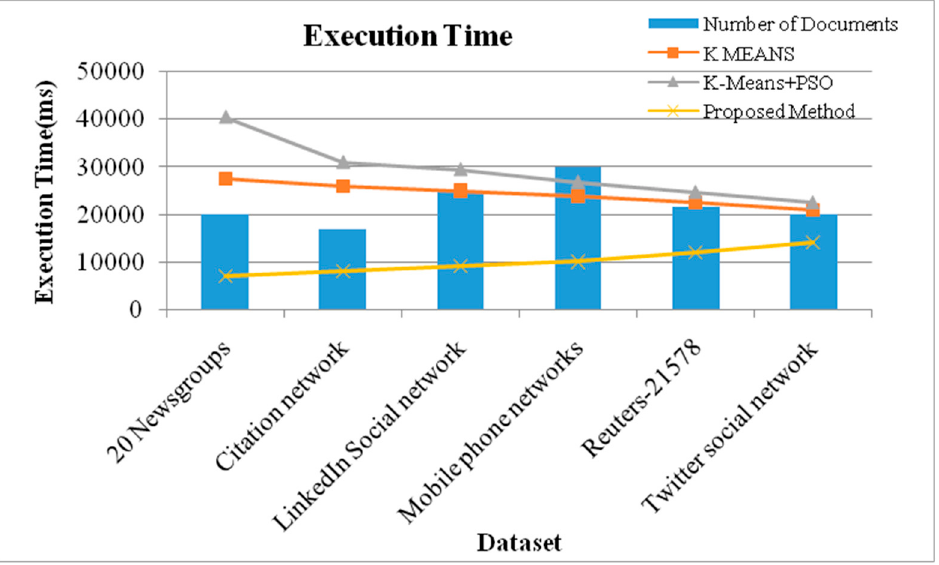
Figure 4. Clustering and analyzing execution time comparison.